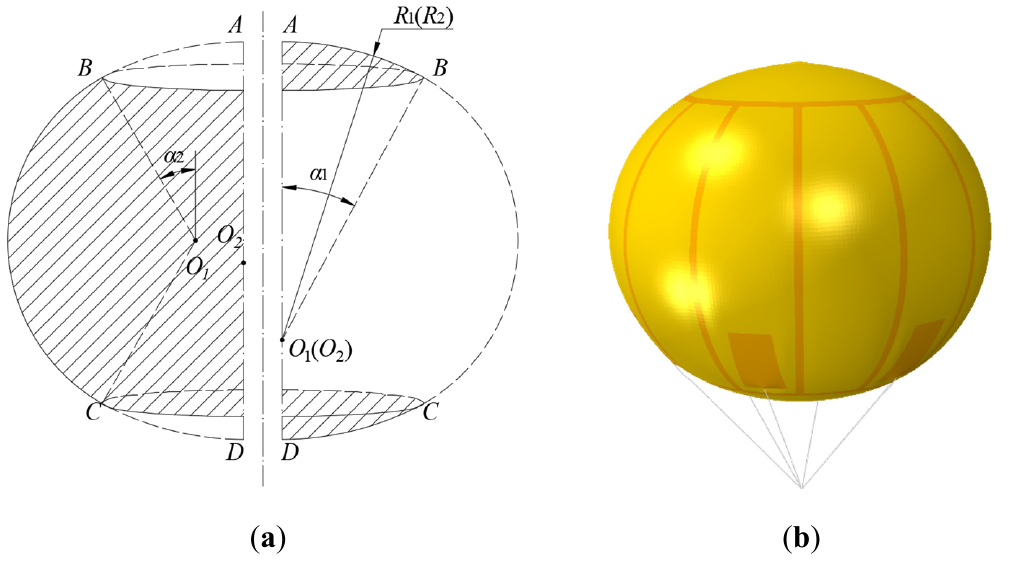
Figure 6. ( a ) Layout of the parameterization of the geometry of the 1 m model; ( b ) geometry model adopted in the simulation.